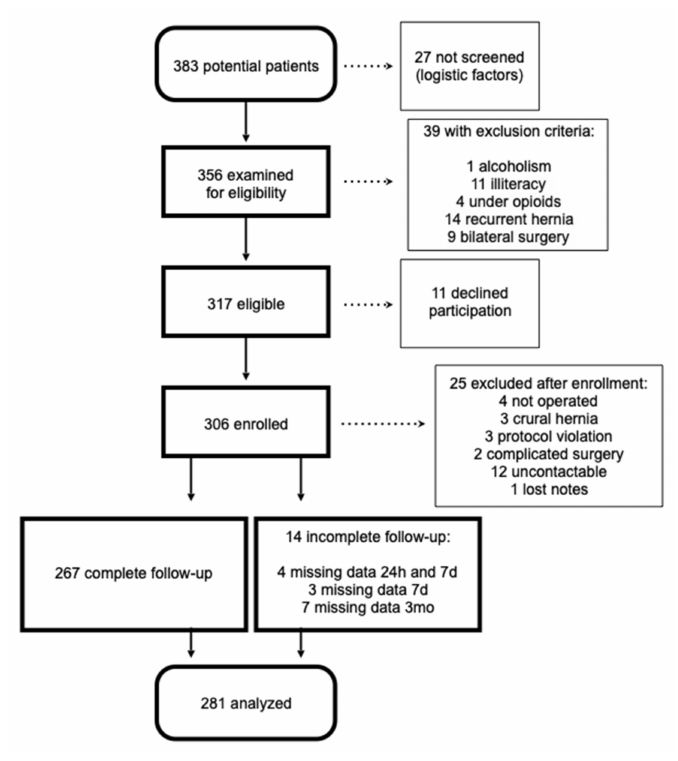
Figure 1. STROBE diagram of patient